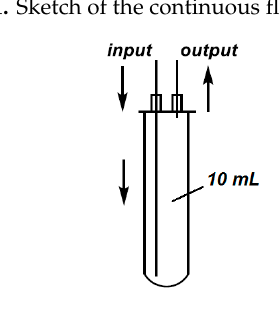
Figure 2. The commercial continuous flow cell.